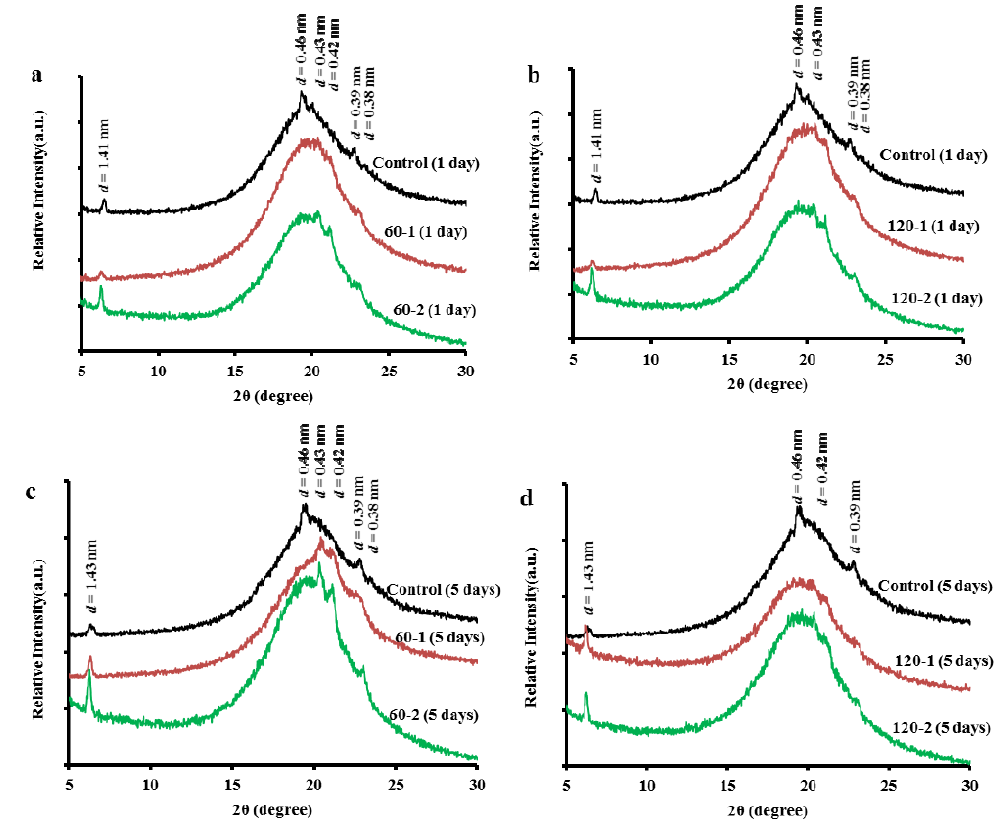
Figure 4. X-ray diffraction patters for PS/PO samples crystallized at 0 °C for 1 day ( a , b ) and 5 days ( c , d ) treated under 60 MPa ( a , c ) and 120 MPa ( b , d ), respectively (all the curves were shifted for